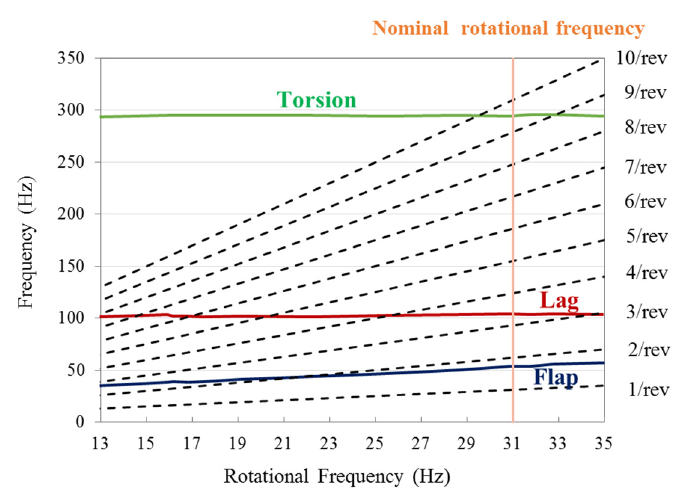
Figure 4. Fan plot of the first modes.